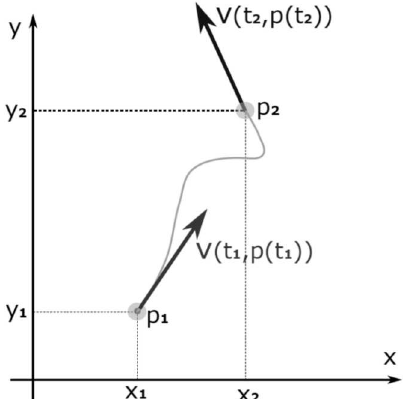
Figure 1. Lagrangian approach – the fluid molecule in time t 1 is situated at point p 1 = p ( t 1 ) and moves at the velocity ~v ( t 1 , p ( t 1 )) . Then, it moves between moments t 1 and t 2 along the path, reaching in time t 2